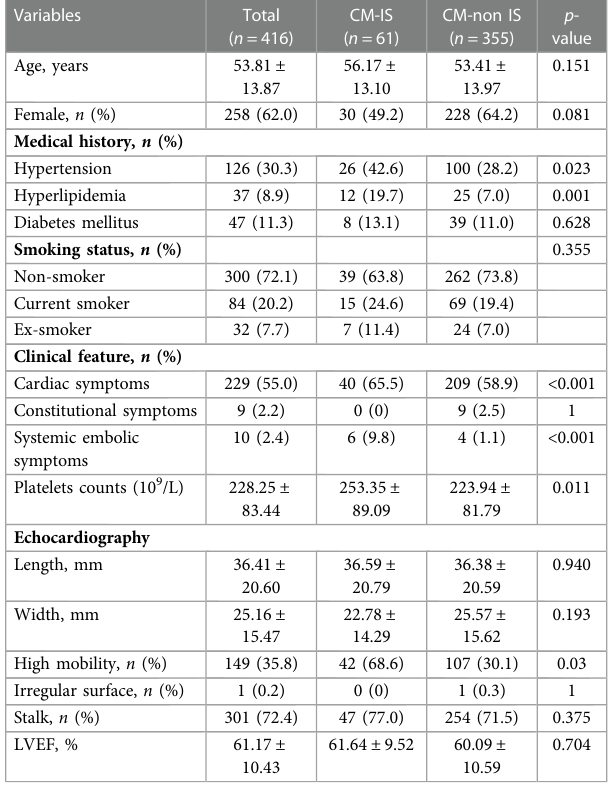
TABLE 2 Risk factors of CM-IS: univariate and multivariate binary logistic regression analysis.